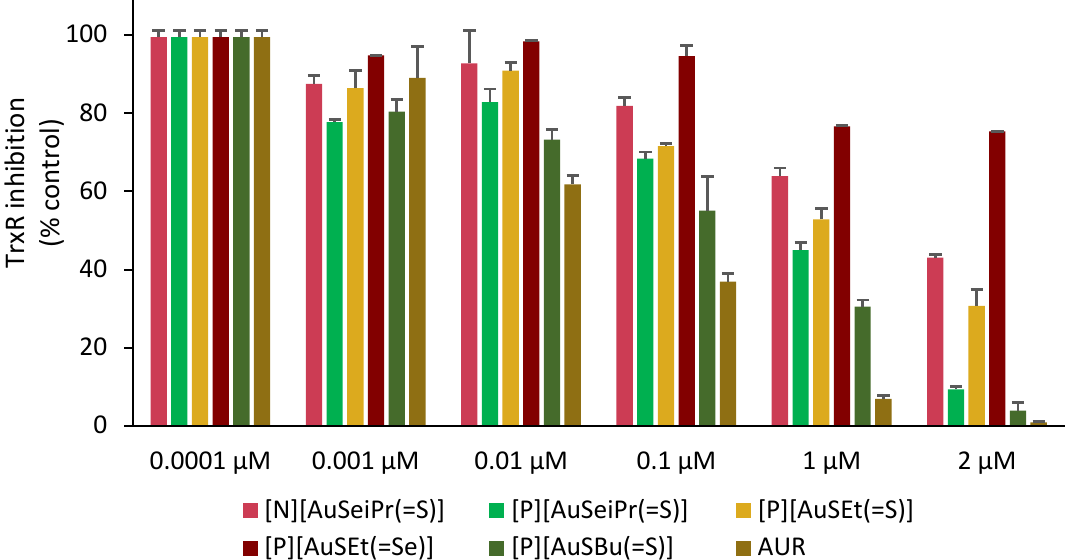
Figure 7. Inhibition of TrxR by the selected complexes under study [ N ][AuSe i Pr(=S)], [ P ][AuSe i Pr(=S)], [ P ][AuSEt(=S)], [ P ][AuSEt(=Se)], [ P ][AuSBu(=S)] and Auranofin (AUR). Data are shown as the mean ± SD of two independent experiments carried out with four replicates for each complex concentration.